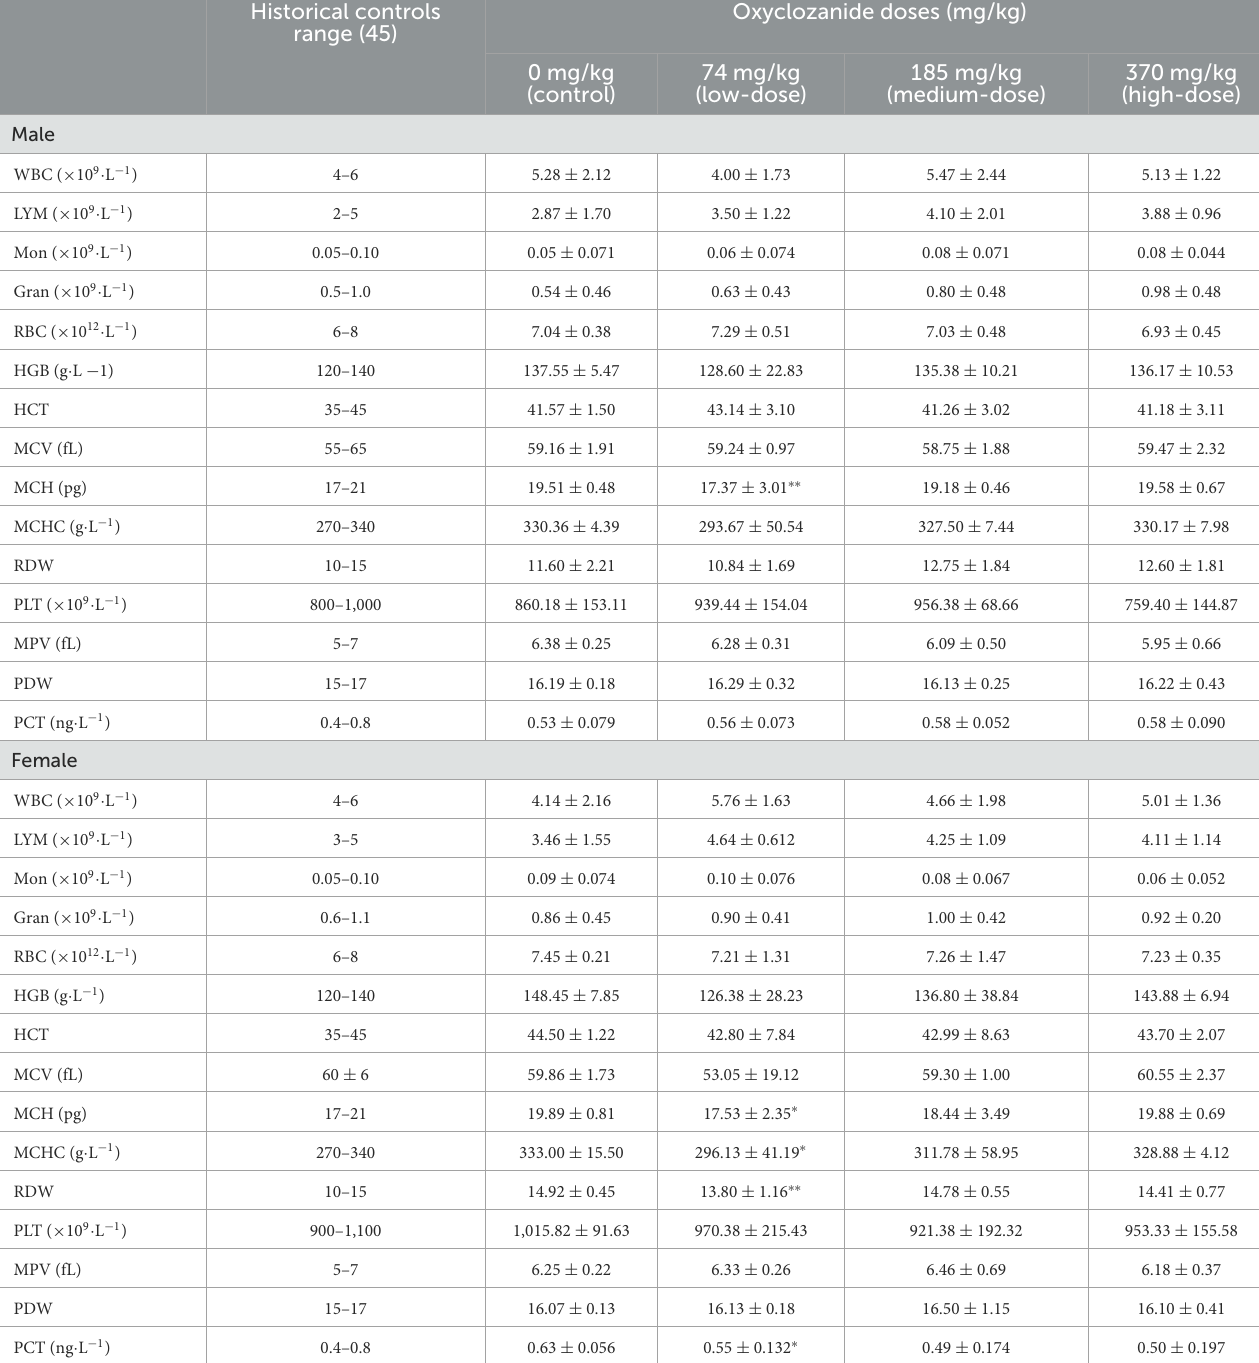
TABLE 2 Haematological values of rats in oxyclozanide-treated group and control group. Historical controls range